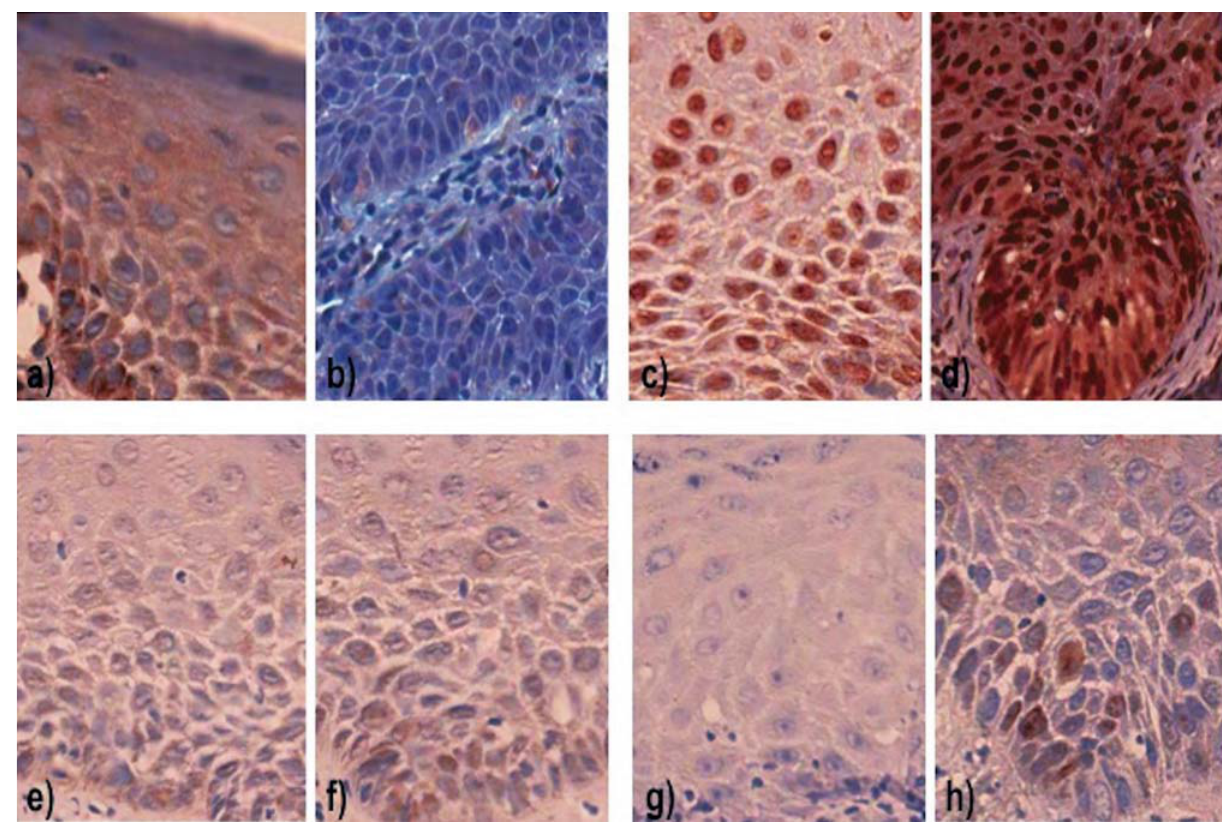
Figure 3- Immunohistochemistry (400X): p16 nuclear and cytoplasmic staining basal and suprabasal layers – oral lichen planus (OLP) area (a); p16 nuclear and cytoplasmic staining basal and suprabasal layers – in situ oral carcinoma (ISOC) area (b); BUB3 nuclear staining - OLP area (c); BUB3 nuclear staining - ISOC area (d); p53 nuclear staining - OLP area (e); p53 nuclear staining - ISOC area (f); Ki67 negative - OLP area (g); Ki67 nuclear staining basal and suprabasal layers - ISOC area